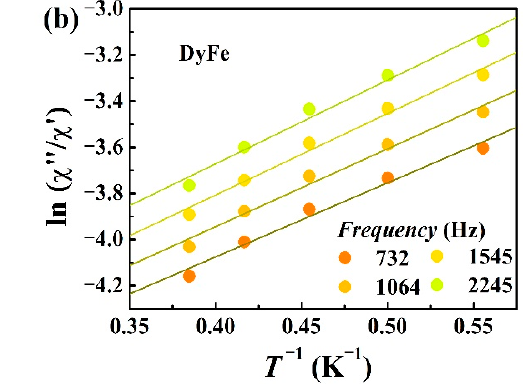
Figure 6. Imaginary parts of ac magnetic susceptibility for the 1 (DyCr) ( a ) and 2 (DyFe) ( b ) complexes, measured at the externally applied magnetic field H dc = 1 kOe.